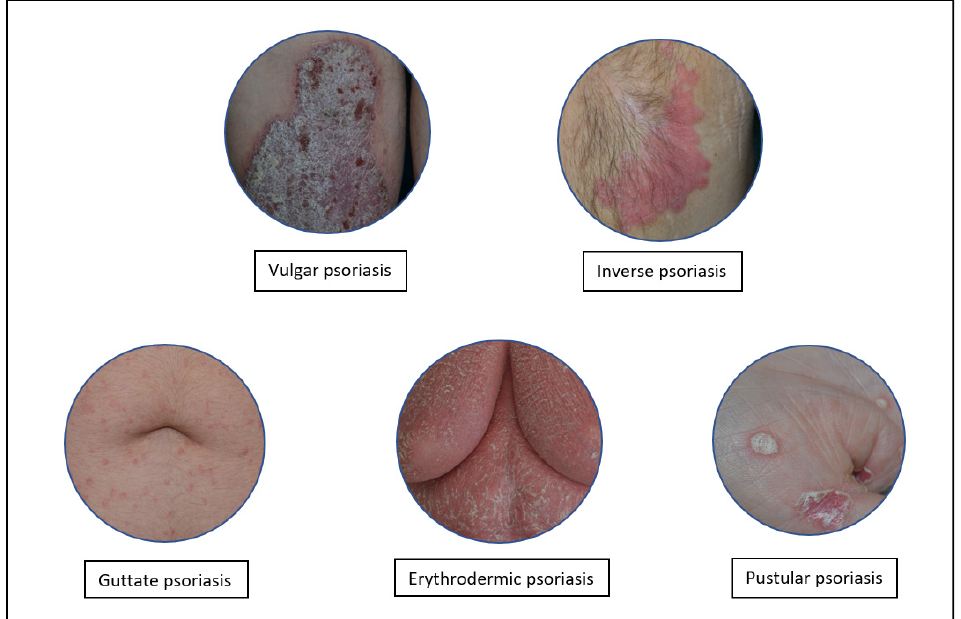
Figure 1. Different types of psoriasis.